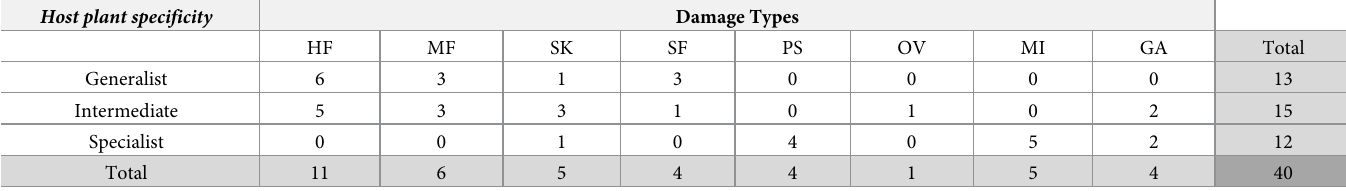
Table 1. Richness of damage types by functional feeding group and host plant specialization on Catula gettyi